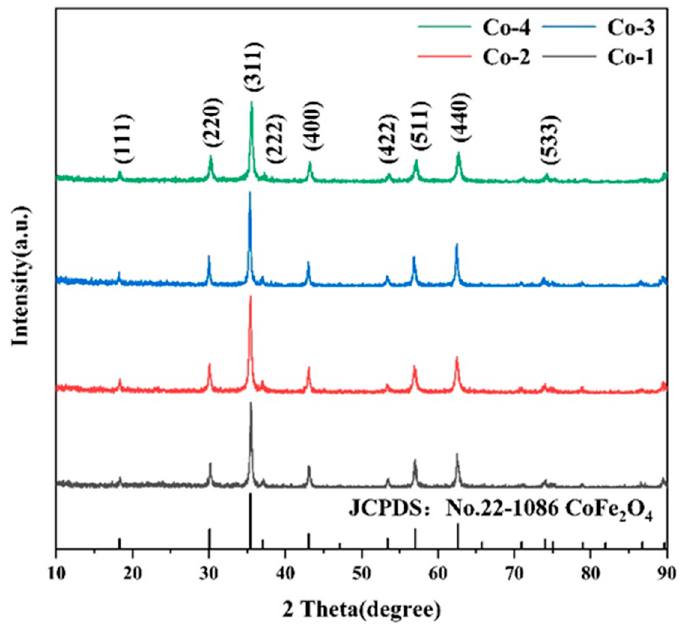
Figure 2. XRD patterns of CoFe 2 O 4 /SWCNTs composites prepared under different experimental pa- rameters.